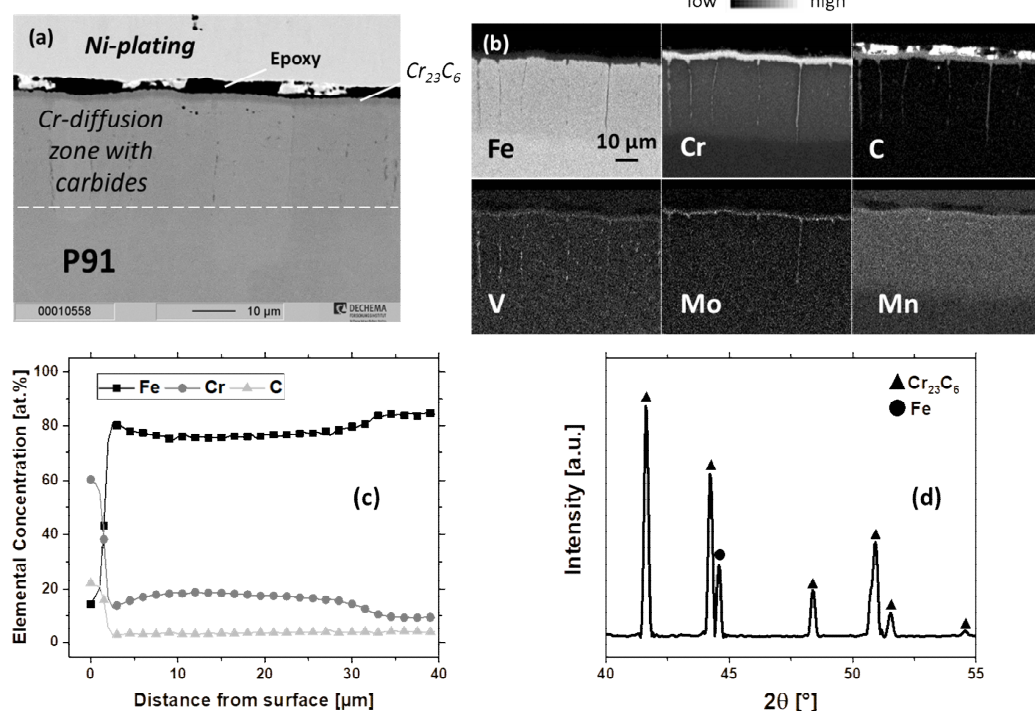
Figure 2. ( a ) Cross-sectional back scattered electron (BSE) image, ( b ) elemental distribution maps and ( c ) quantitative line scans of Fe, Cr and C as well as ( d ) X-ray di ff raction (XRD) pattern of Cr-di ff usion coated P91. Please note the low adherence of the Ni-plating, resulting in the incorporation of the epoxy into the surface of the coating during